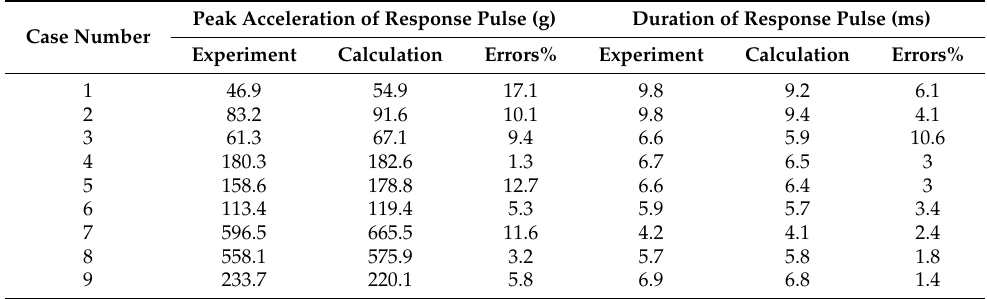
Figure 11. Simulated and measured responses of the rubber isolator in the ninth case. Table 4. Amplitudes and durations of pulses obtained by calculations and